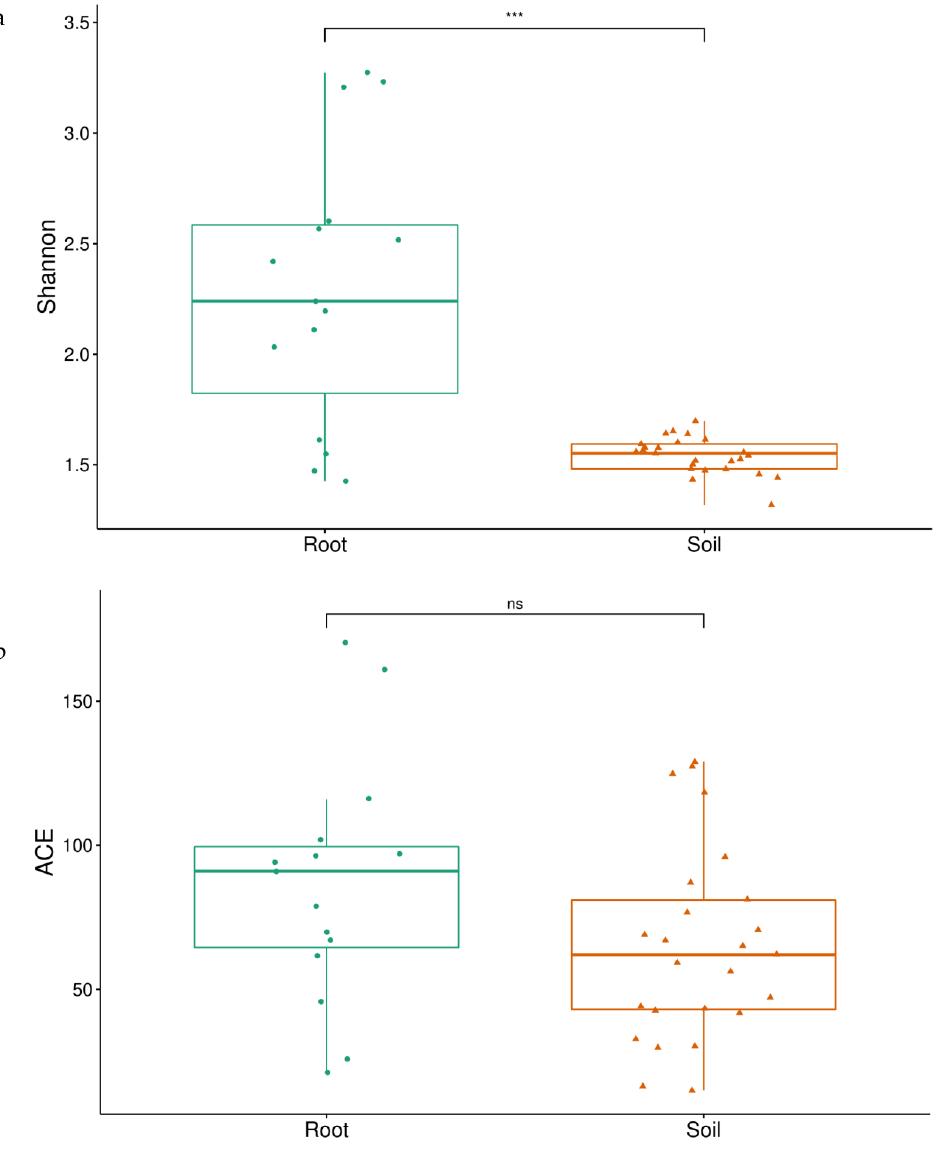
Figure 5. Alpha diversity of fungal communities present in conservative and semi-conservative cocoa crops. ( a ) Shannon index ( b ) ACE index. *** represents significant values with p < 0.05, ns = not significant. The circles represent fine and aroma cocoa roots while the triangles represent soil